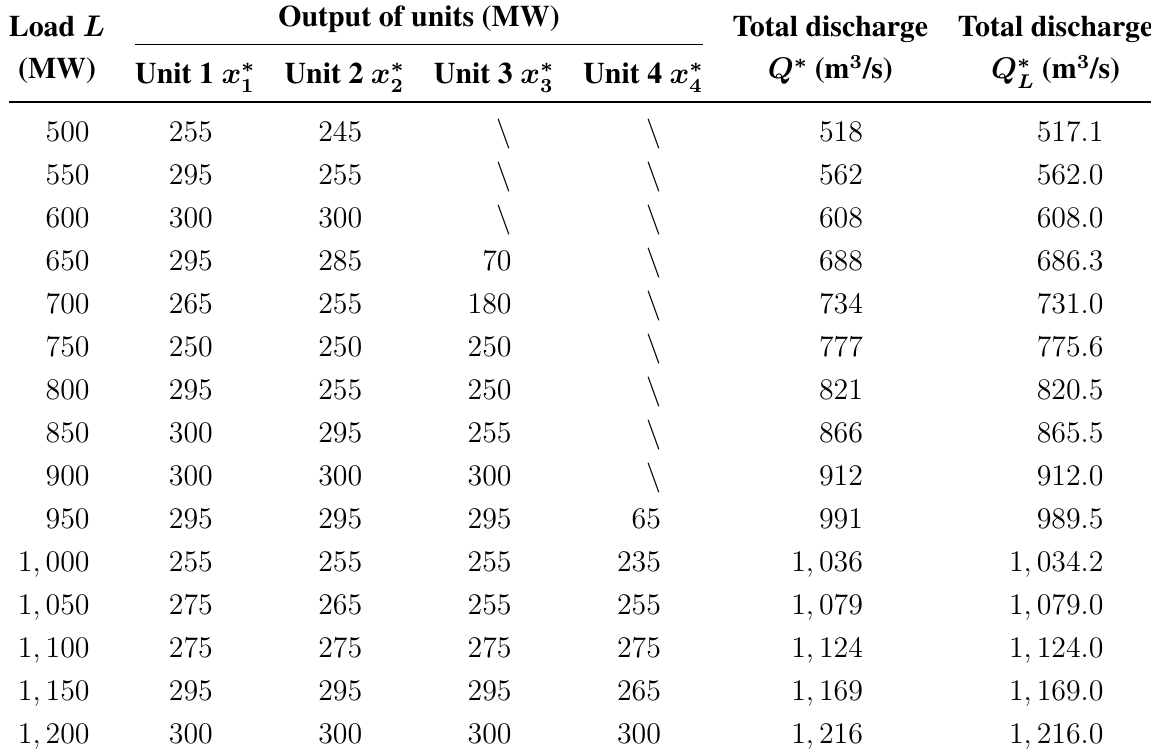
Table 1. The results of global optimal solution to the OLD problem by using